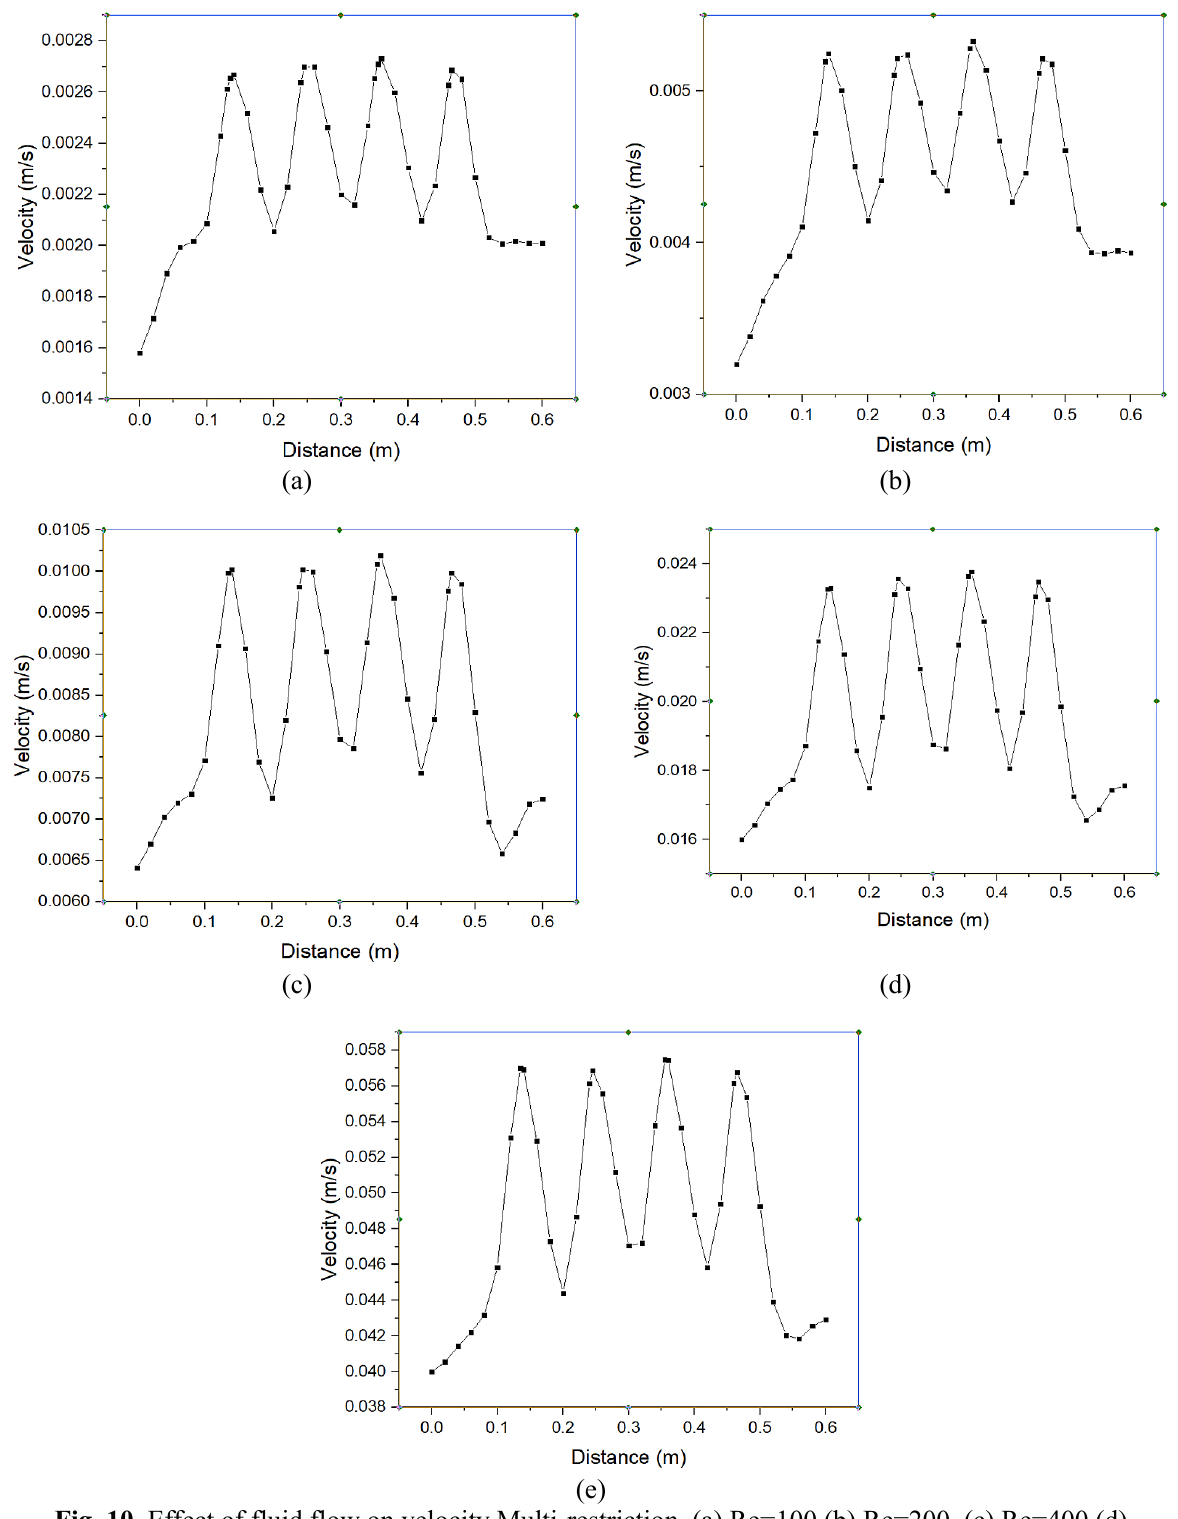
Fig. 10. Effect of fluid flow on velocity Multi-restriction (a) Re=100 (b) Re=200 (c) Re=400 (d) Re=1000 (e) Re= 2500